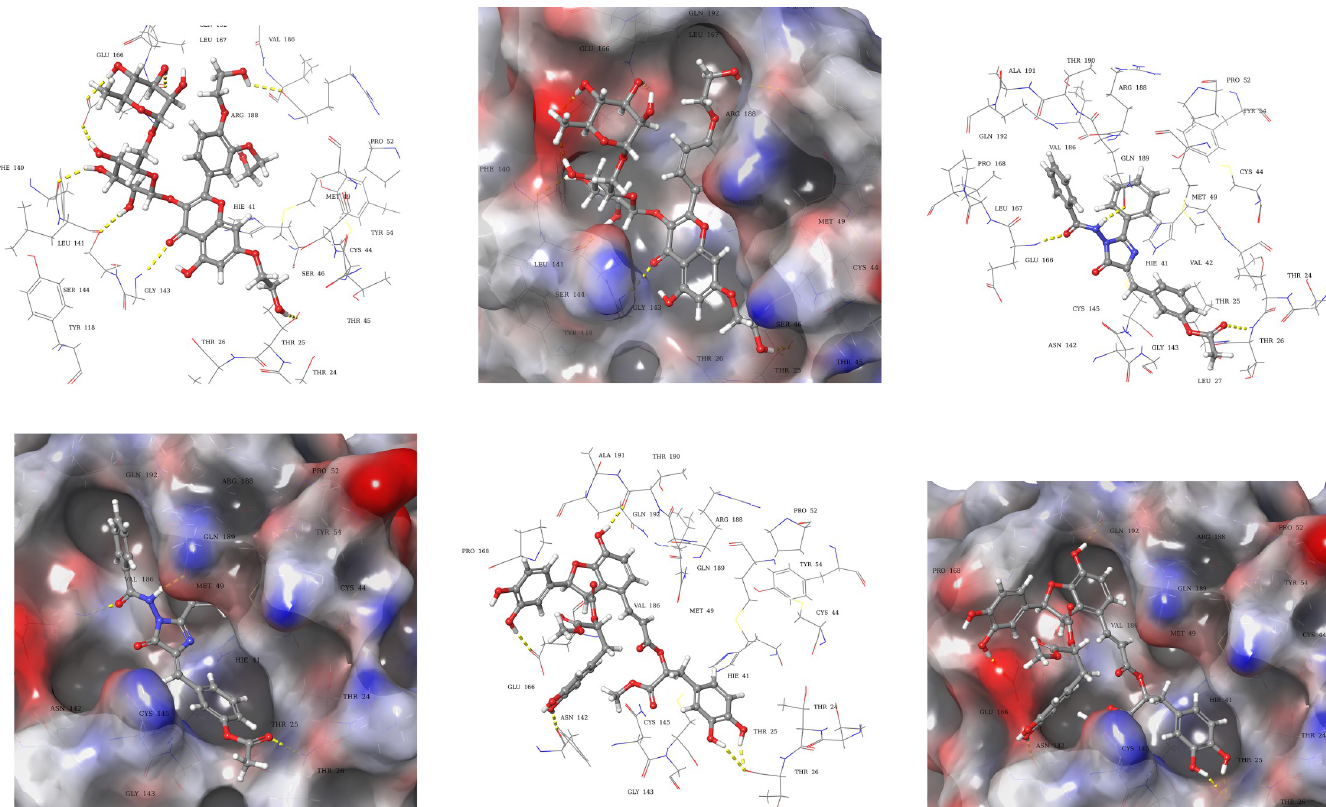
Fig 4. Docked poses and molecular interactions of compound 1, 2, and 3 in binding site of 6LU7. 3D-Ligand interaction and 3D molecular surface diagrams of compounds 1 ( a ) and ( b ), compound 2 ( c) and ( d ) compound 3 ( e ) and ( f ), showing the docked pose in the binding site of 2019-nCOV 3CL hydrolase (Mpro). The hydrogen bonds are represented as yellow dotted